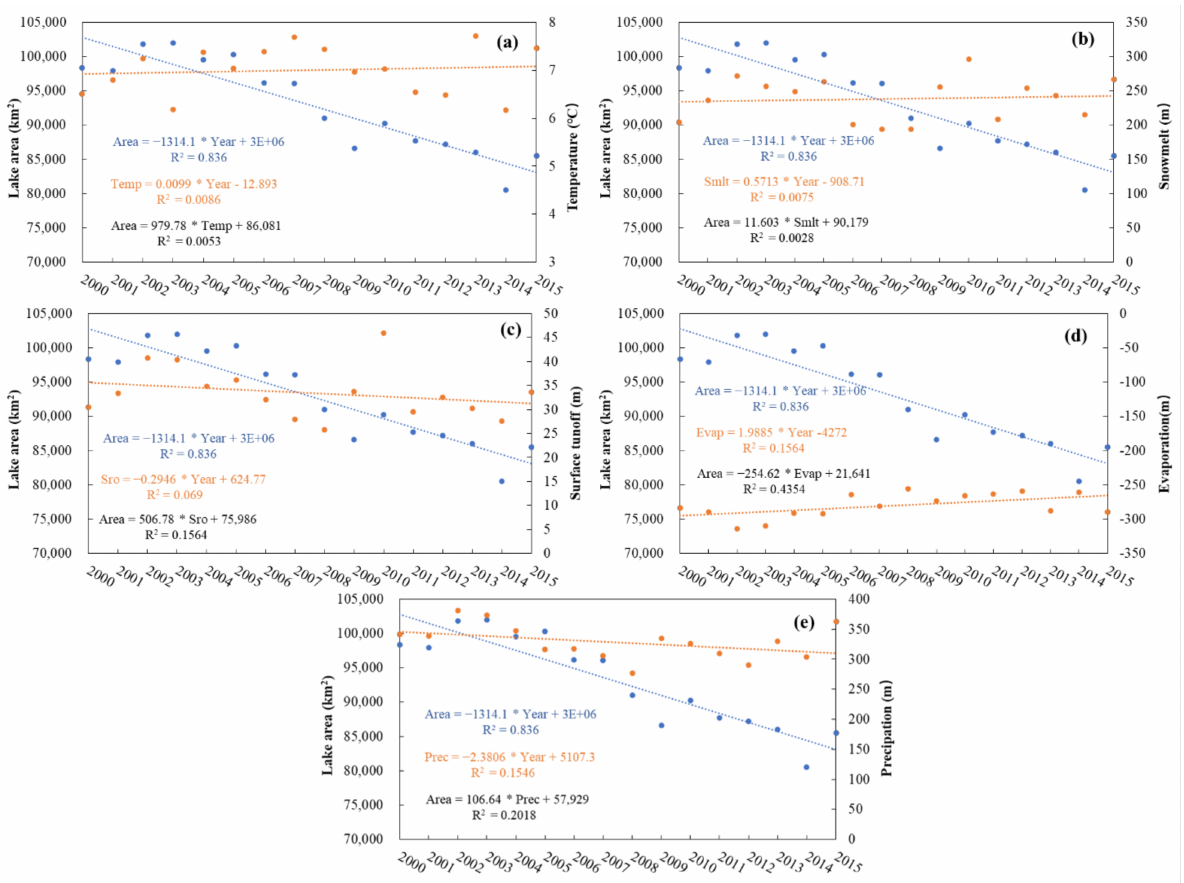
Figure 12. Correlations between lake area and temperature ( a ), snowmelt ( b ), surface runoff ( c ), evaporation ( d ) and precipitation ( e